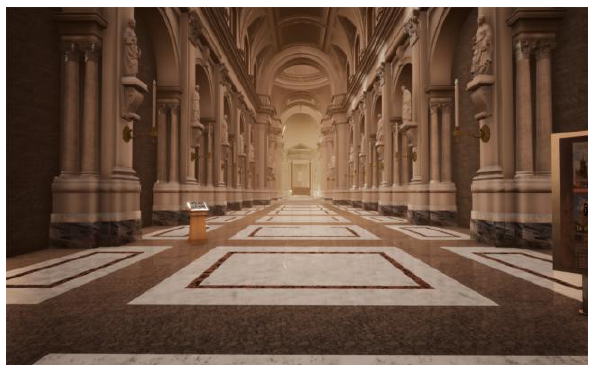
Figure 14: Perspective view of today’s Cathedral.